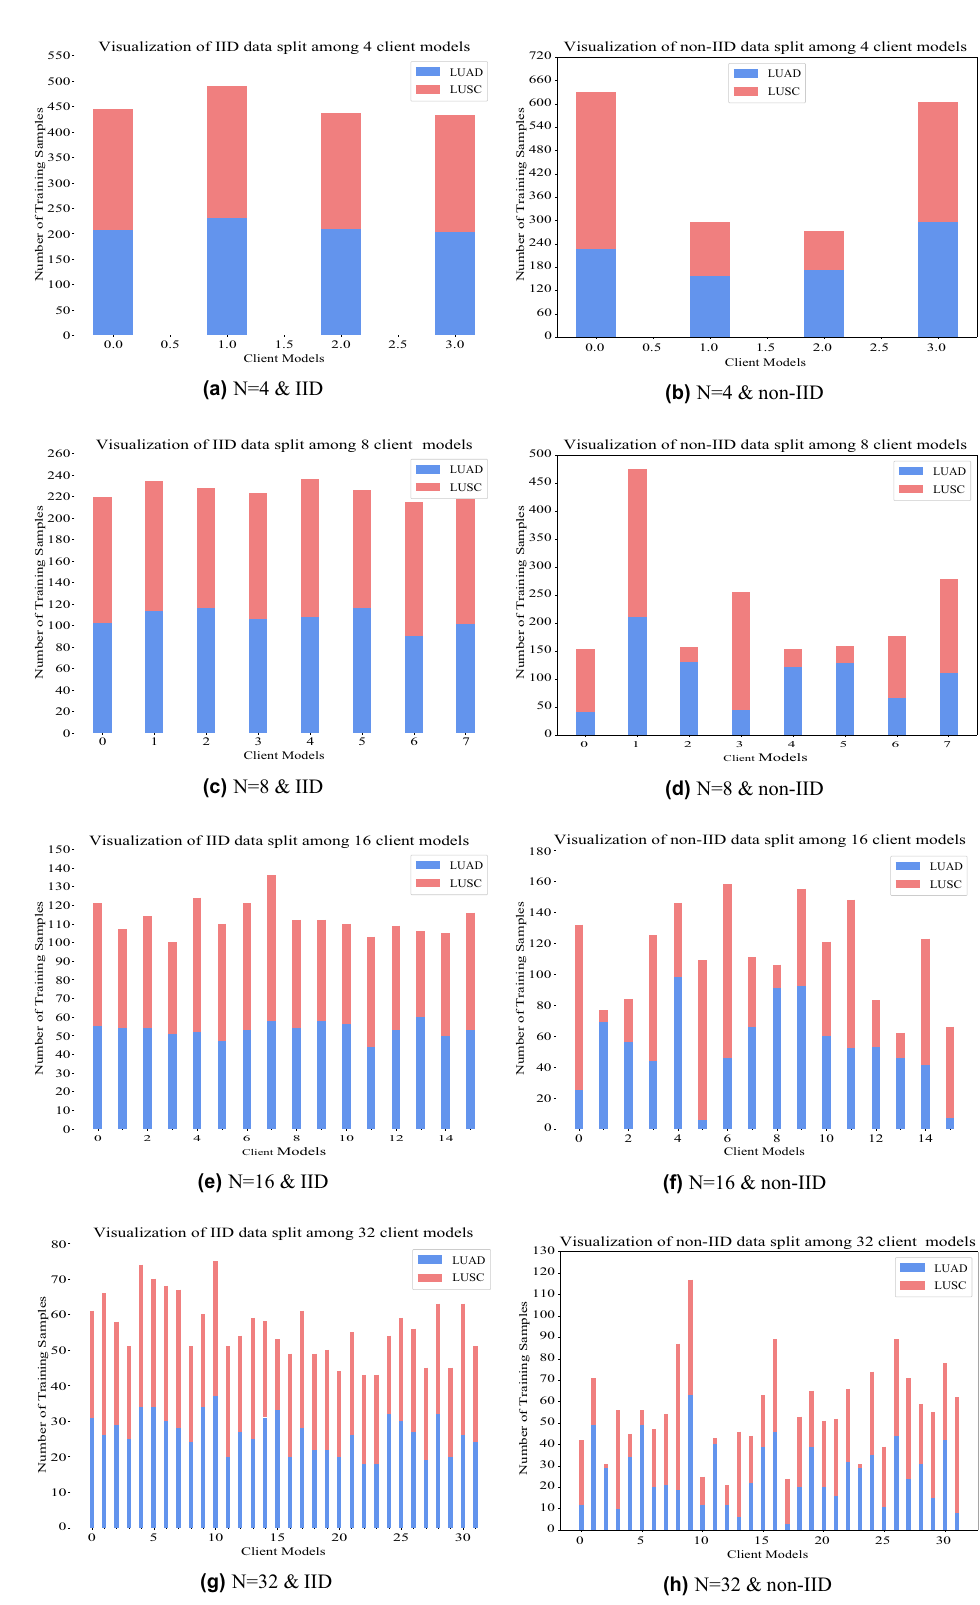
Figure 5. Visualisation of IID and non-IID distribution of data among client